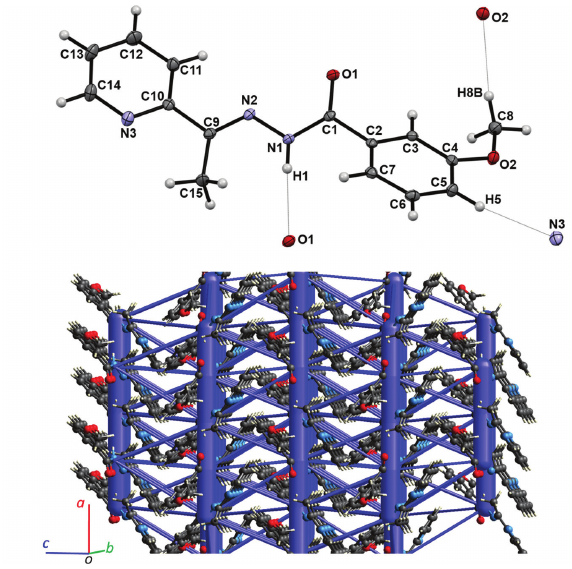
Table 1 contains crystallographic data and Table 2 contains the list of the atoms including atomic coordinates and dis- placement parameters.